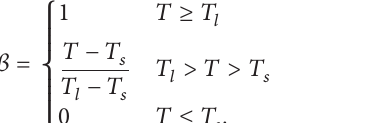
Figure 2: High temperature heat exchange test system.